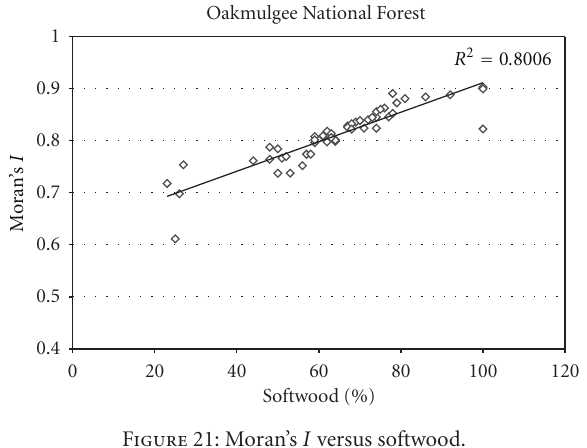
Figure 21: Moran’s I versus softwood.